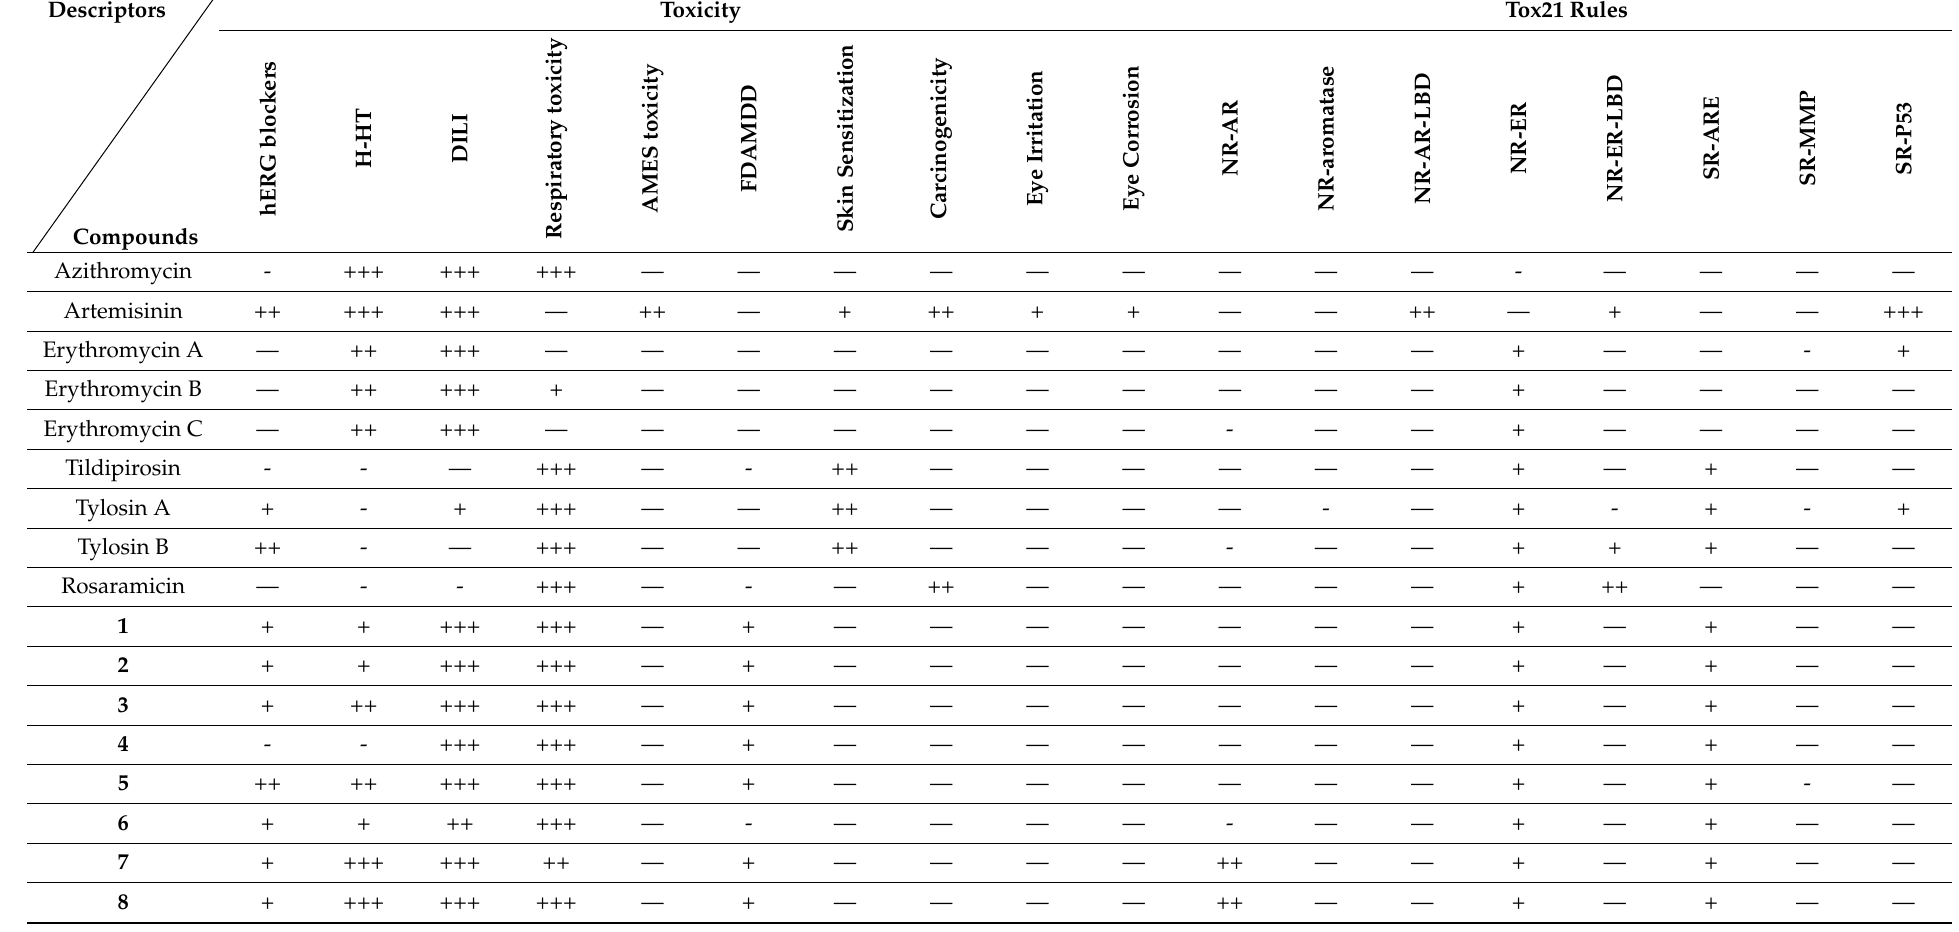
Table 5. Toxicity profiles of selected macrolides and control compounds (azithromycin and artemisinin) in use as